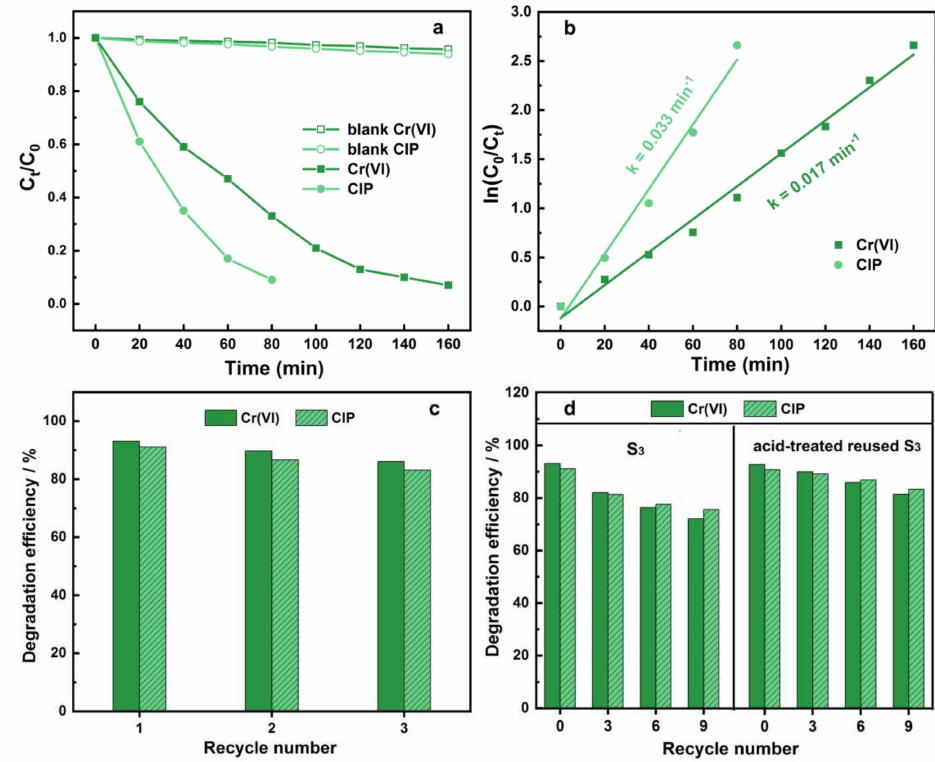
Figure 5. ( a ) Removal efficiency of CIP and Cr(VI) in the mixed solutions by S 3 sample; ( b ) the corresponding first-order kinetics and rate constants; ( c ) reusable degradation activity of S 3 for three cycles; ( d ) simultaneous removal of CIP and Cr(VI) in the presence of S 3 with and without acid treatment for nine